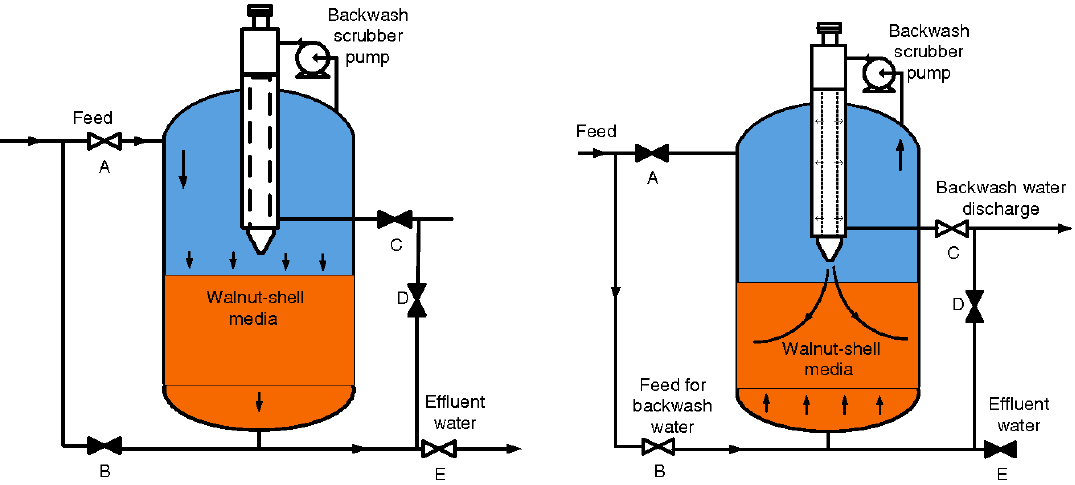
Figure 5. Typical nutshell-media technology operation during ( left ) filtration and ( right ) backwash cycles [95].